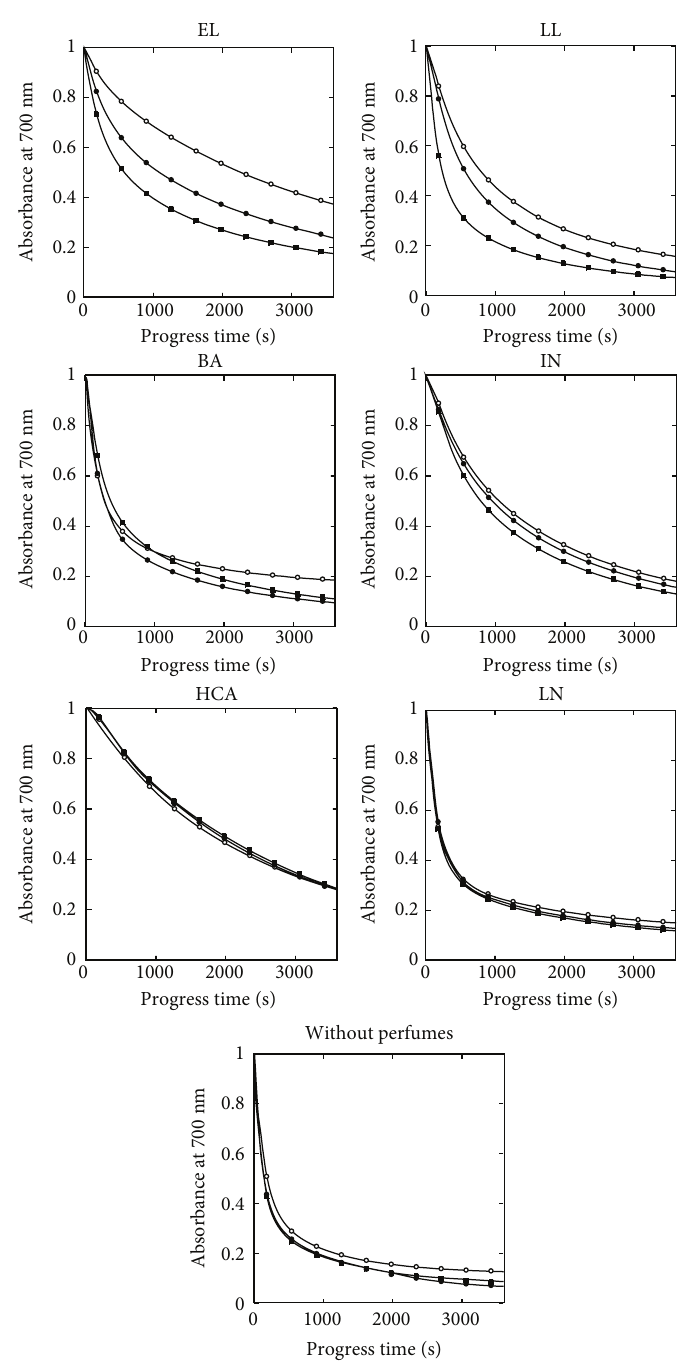
Figure 2: Time-dependent changes in absorbance at 700 nm of O/W emulsion after 0-, 30-, and 60-minute light irradiation. Open circle ( ∘ ), closed circle ( ∙ ), and closed square ( ◼ ) correspond to the absorbance change after 0-, 30-, and 60-minute light irradiation,